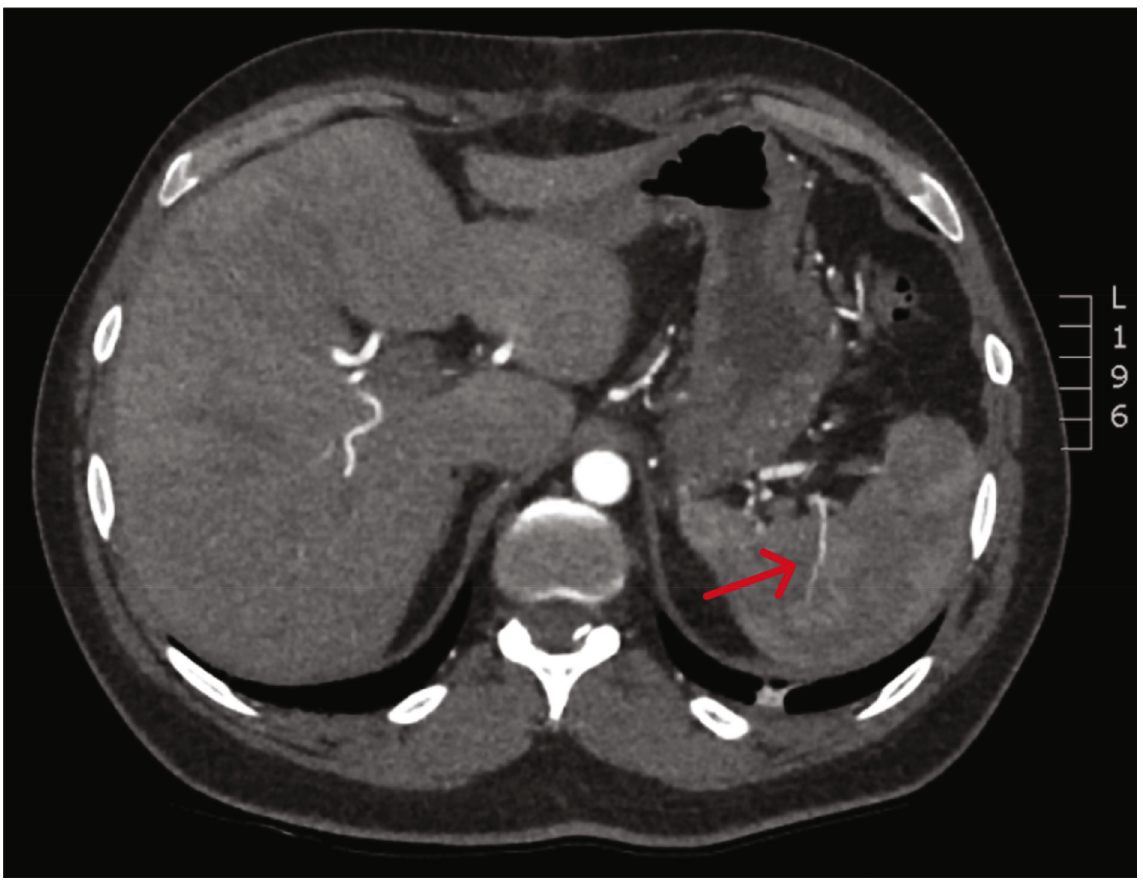
Figure 3: CT angiogram con fi rming adequate collateral perfusion of the spleen 3 weeks